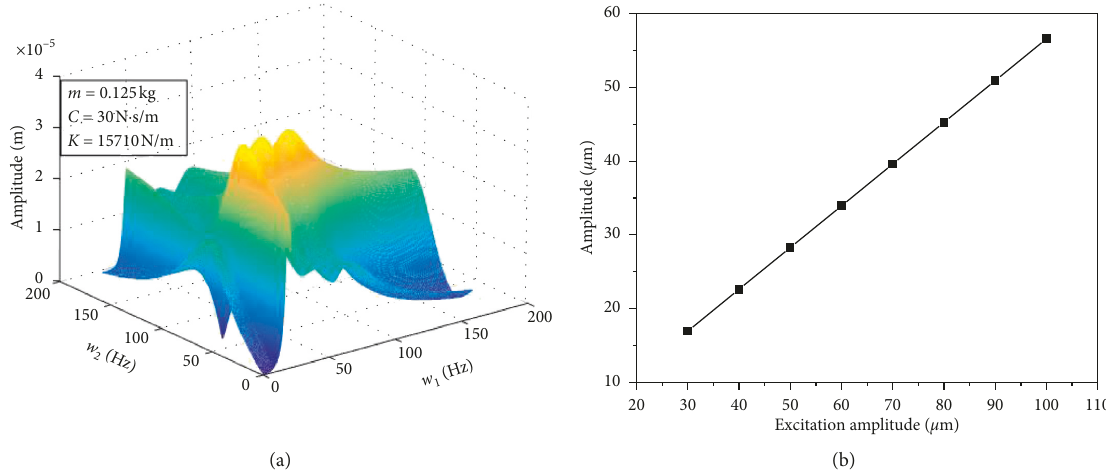
Figure 4: Effect of excitation on the output spectrum. (a) Nonlinear output spectrum with Ar � 30 μ m. (b) Relationship between excitation amplitude and response peak.